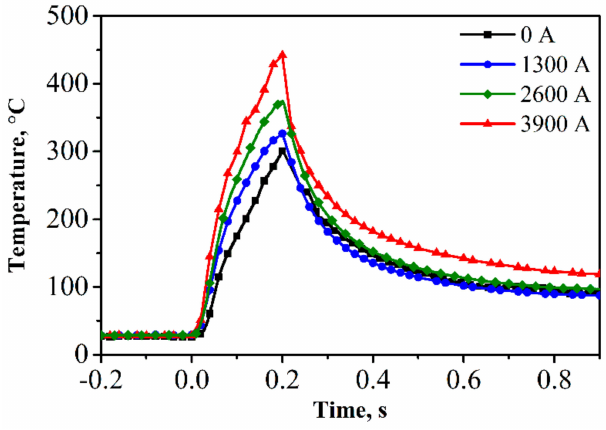
Figure 4. Measured temperatures for various currents.